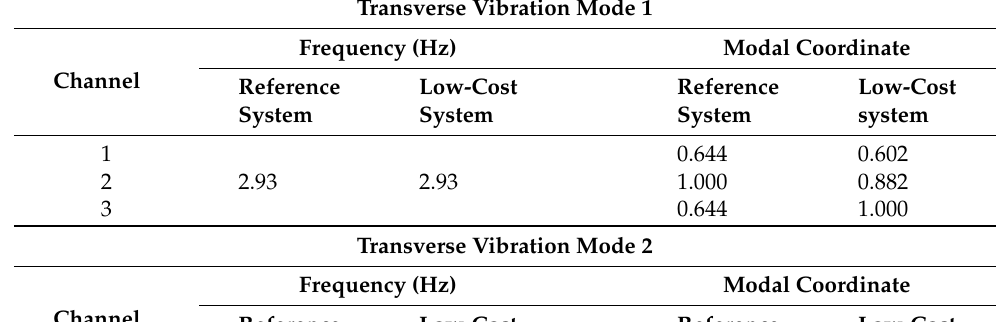
Table 10. Transverse natural frequencies and mode shapes identified of the steel structure by both monitoring systems.